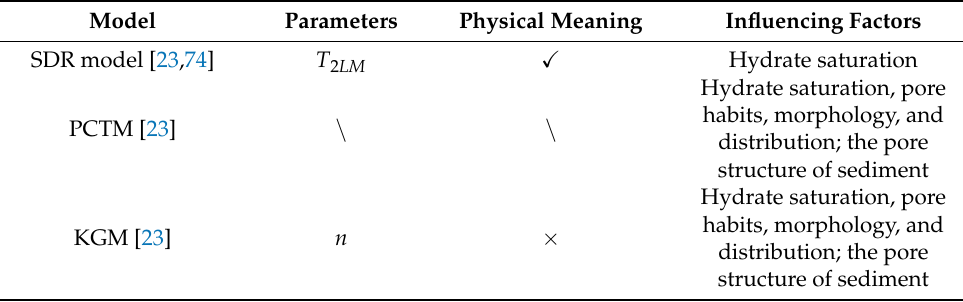
Table 2. Characteristics of classical models for permeability prediction of